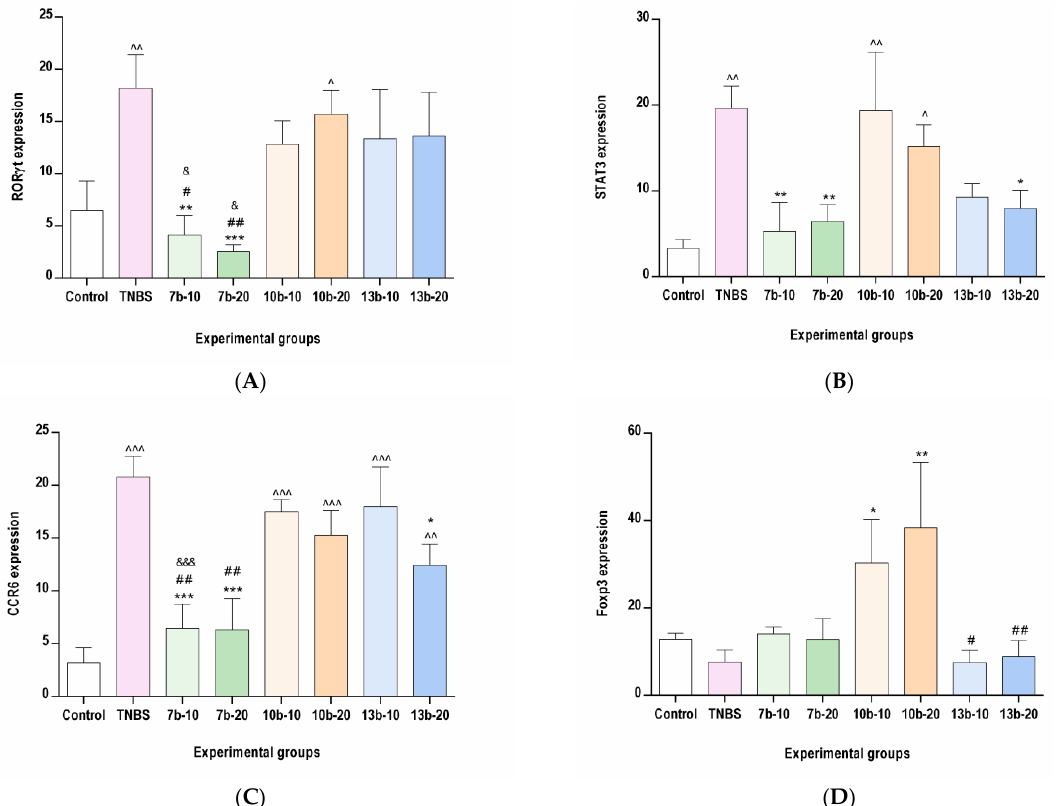
Figure 3. The impact of compounds 7b , 10b and 13b on RORγt ( A ), STAT3 ( B ), CCR6 ( C ), and Foxp3 ( D ) expression in the colon tissues in experimental groups. Control, control group; TNBS, group receiving only TNBS; 7b -10 and 7b -20, groups receiving, respectively, 10 or 20 mg/kg of compound 7b and TNBS; 10b -10 and 10b -20, groups receiving, respectively, 10 or 20 mg/kg of compound 10b and TNBS; 13b -10 and 13b -20, groups receiving, respectively, 10 or 20 mg/kg of compound 13b and TNBS. Data are presented as mean values ± SD; n = 10 for each group. Analyses were performed using the one- way ANOVA and Tukey’s post hoc test. Differences ^ p < 0.05 ^^ p < 0.01, ^^^ p < 0.001 vs. control group; * p < 0.05, ** p < 0.01, *** p < 0.001 vs. TNBS group; # p < 0.05, ## p < 0.01 vs. compound 10b at the corresponding dose group; & p < 0.05, &&& p < 0.001 vs. compound 13b at the corresponding dose group were deemed statistically significant.